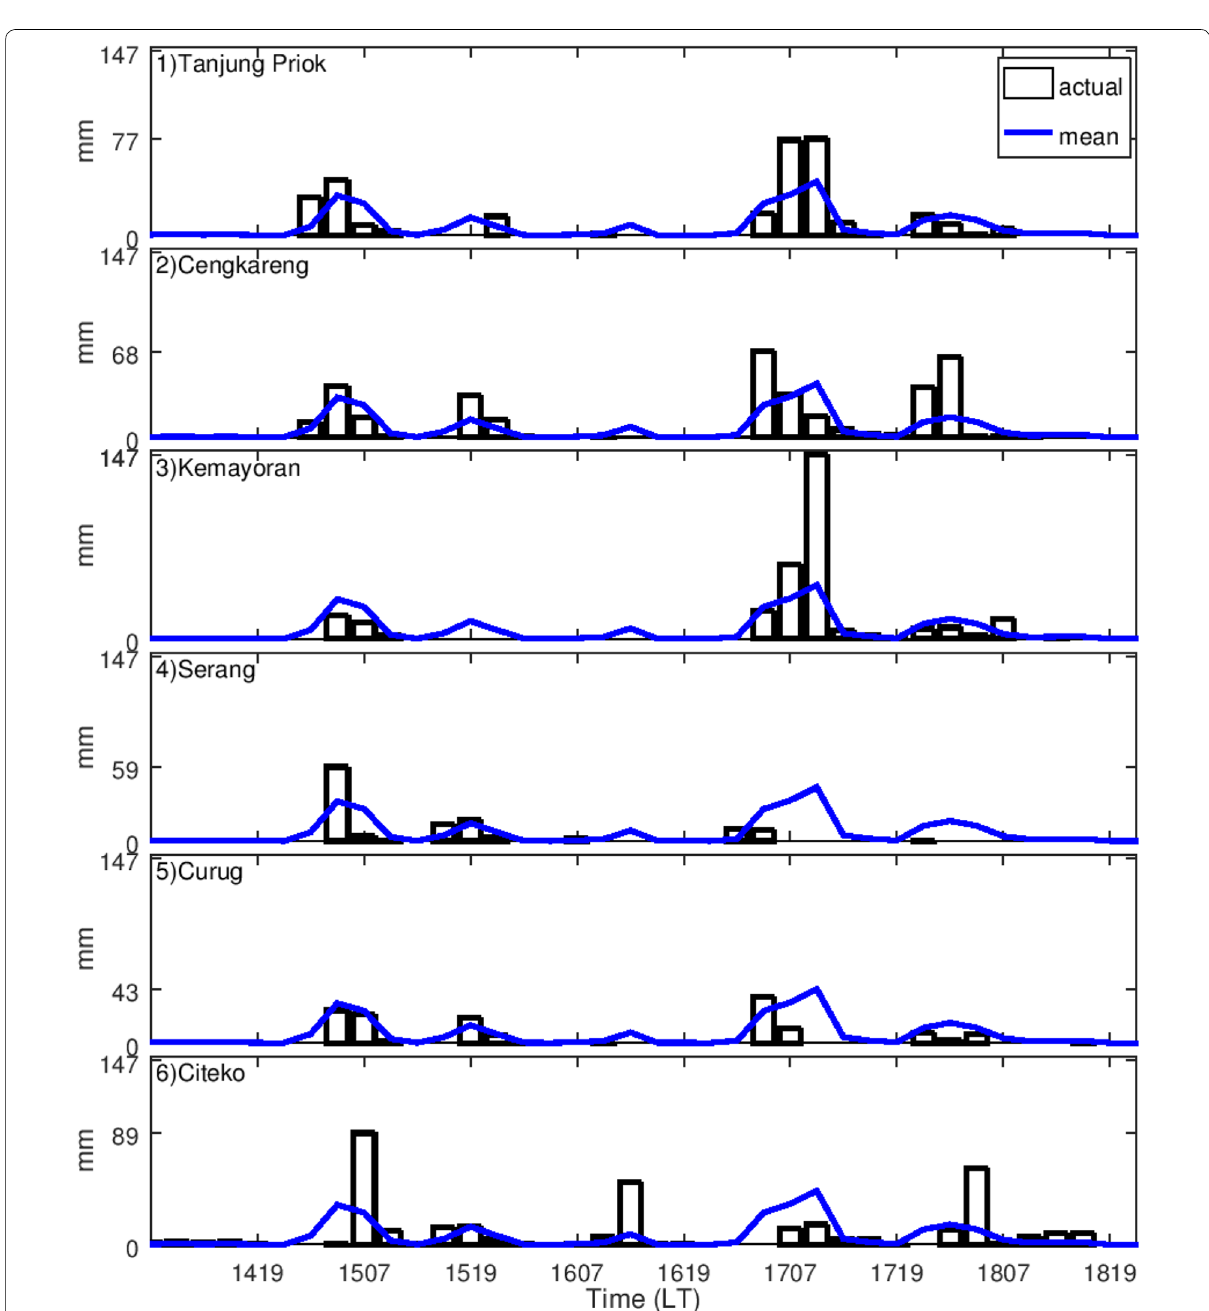
Fig. 3 Time-series of 3 hourly rainfalls from 6 weather stations (bar) and stations averaged (line) during 14–18 January 2013. Horizontal label is date and hour, for example, 1419 denotes 19:00 LT on January 14th,